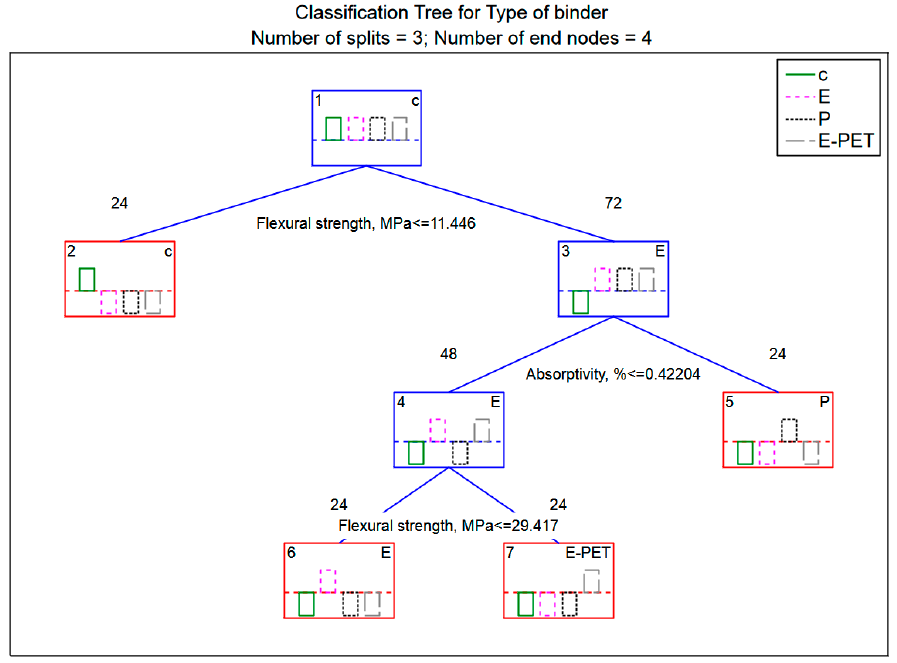
Figure 10. Decision tree.